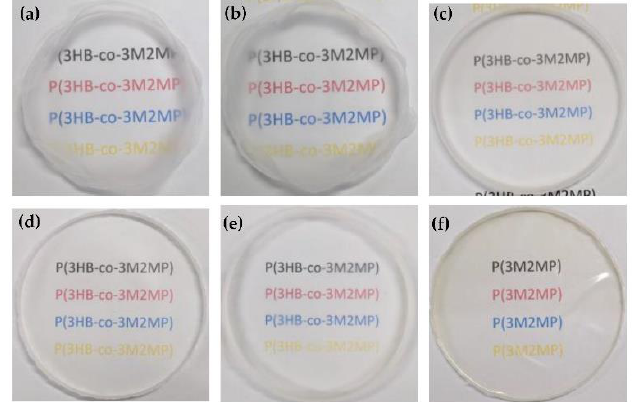
Figure 7. Polymer solvent cast films with increasing 3M2MP units. ( a ) Sample 1 (5.5 mol% 3M2MP); ( b ) Sample 2 (10.1 mol%); ( c ) Sample 3 (34.2 mol%); ( d ) Sample 4 (53.9 mol%); ( e ) Sample 5 (54.8 mol%); ( f ) Sample 7 (100 mol%).